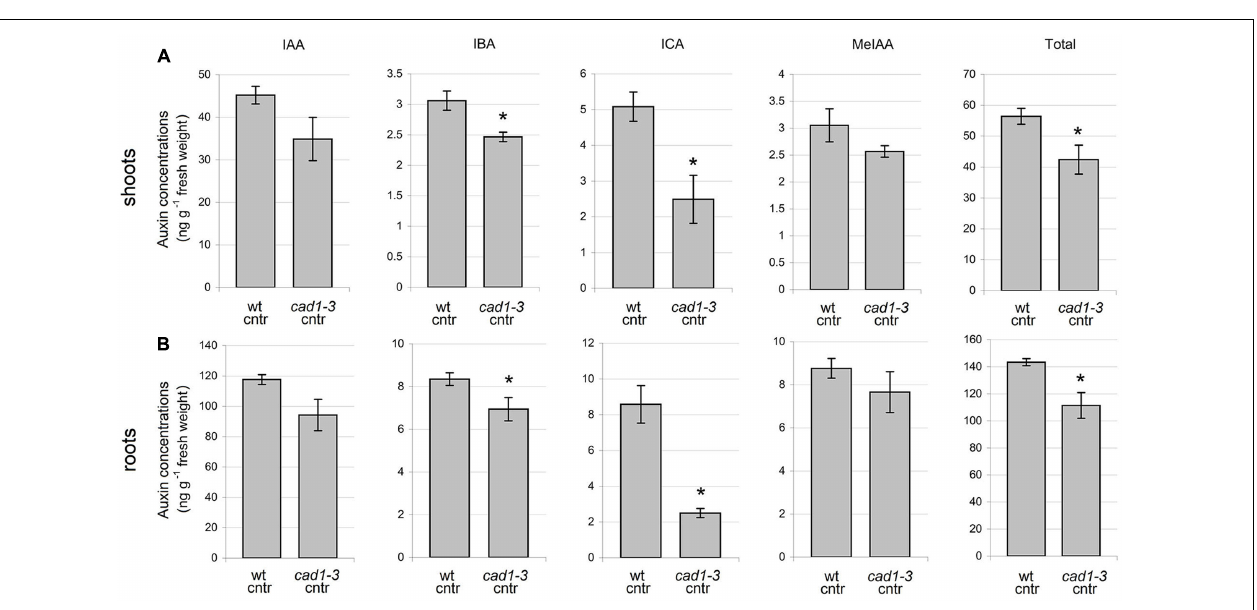
FIGURE 9 | Concentration of auxins in shoots (A) and roots (B) of wt and cad1-3 control (cntr) plants. IAA, indole-3-acetic acid; IBA, indole-3-butyric acid; ICA, indole-3-carboxylic acid; MeIAA, indole-3-acetic acid methyl ester. n = 3, error bars indicate SE; statistically significant differences assessed by the non-parametric Mann–Whitney U -test; ∗ p ≤